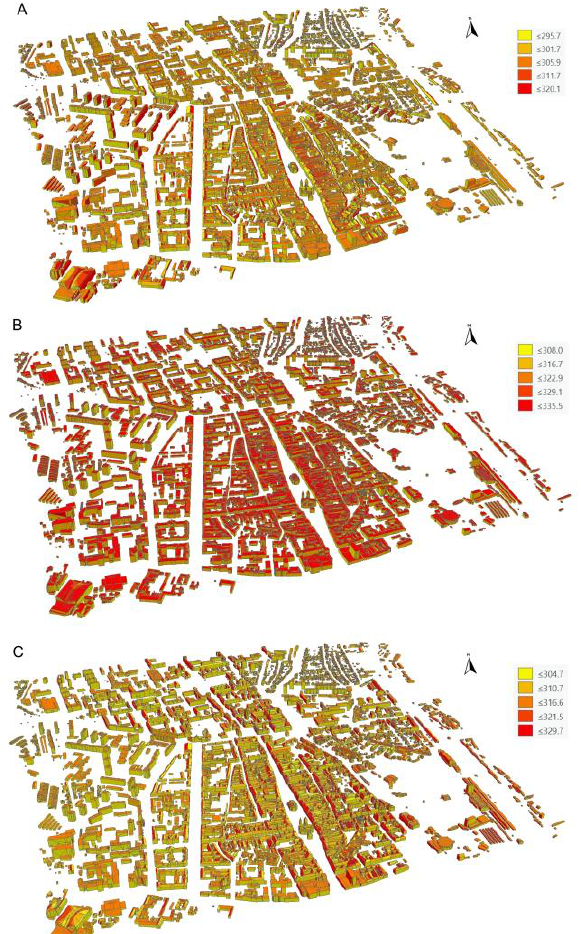
Figure 4. Calculated LST (K) in the city of Košice at A) 7:00, B) 12:00, C) 17:00 on 1